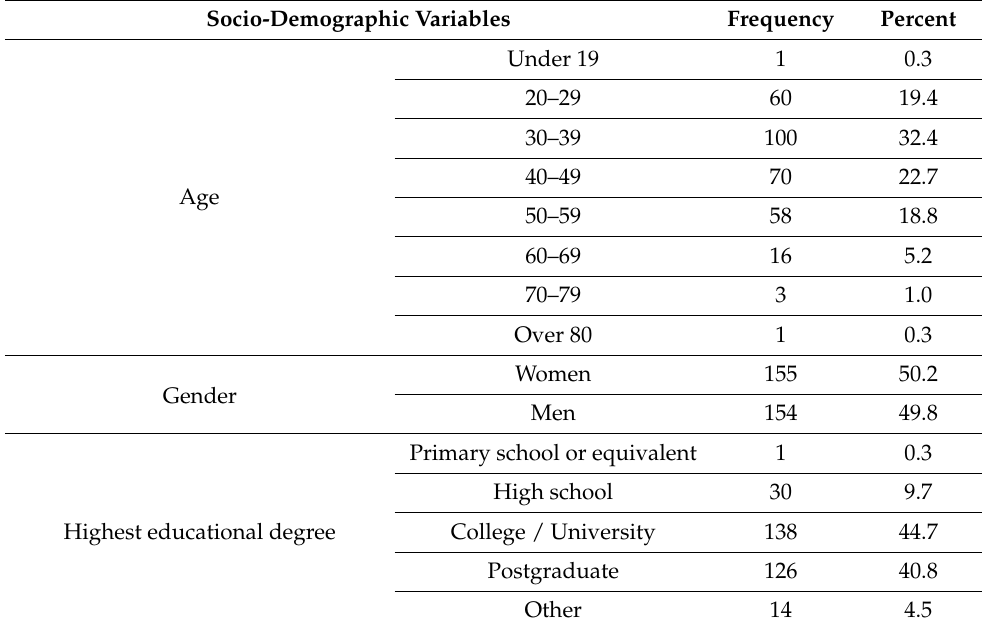
Table 3. Socio-demographic characteristics of the Romanian sample (Source: Authors’ survey